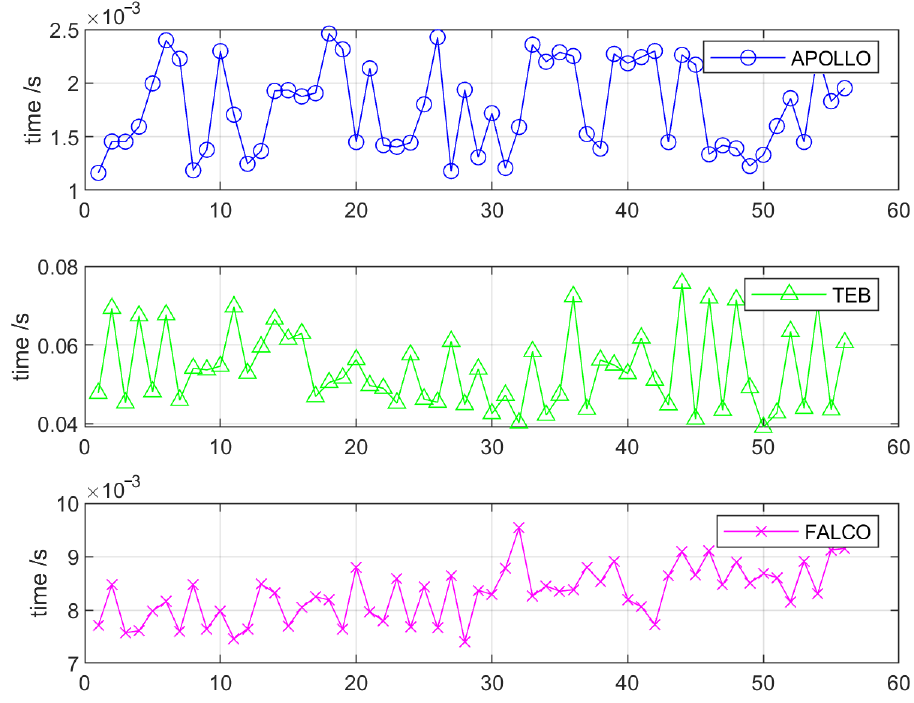
Figure 18. CPU time comparison of APOLLO, TEB and FALCO.